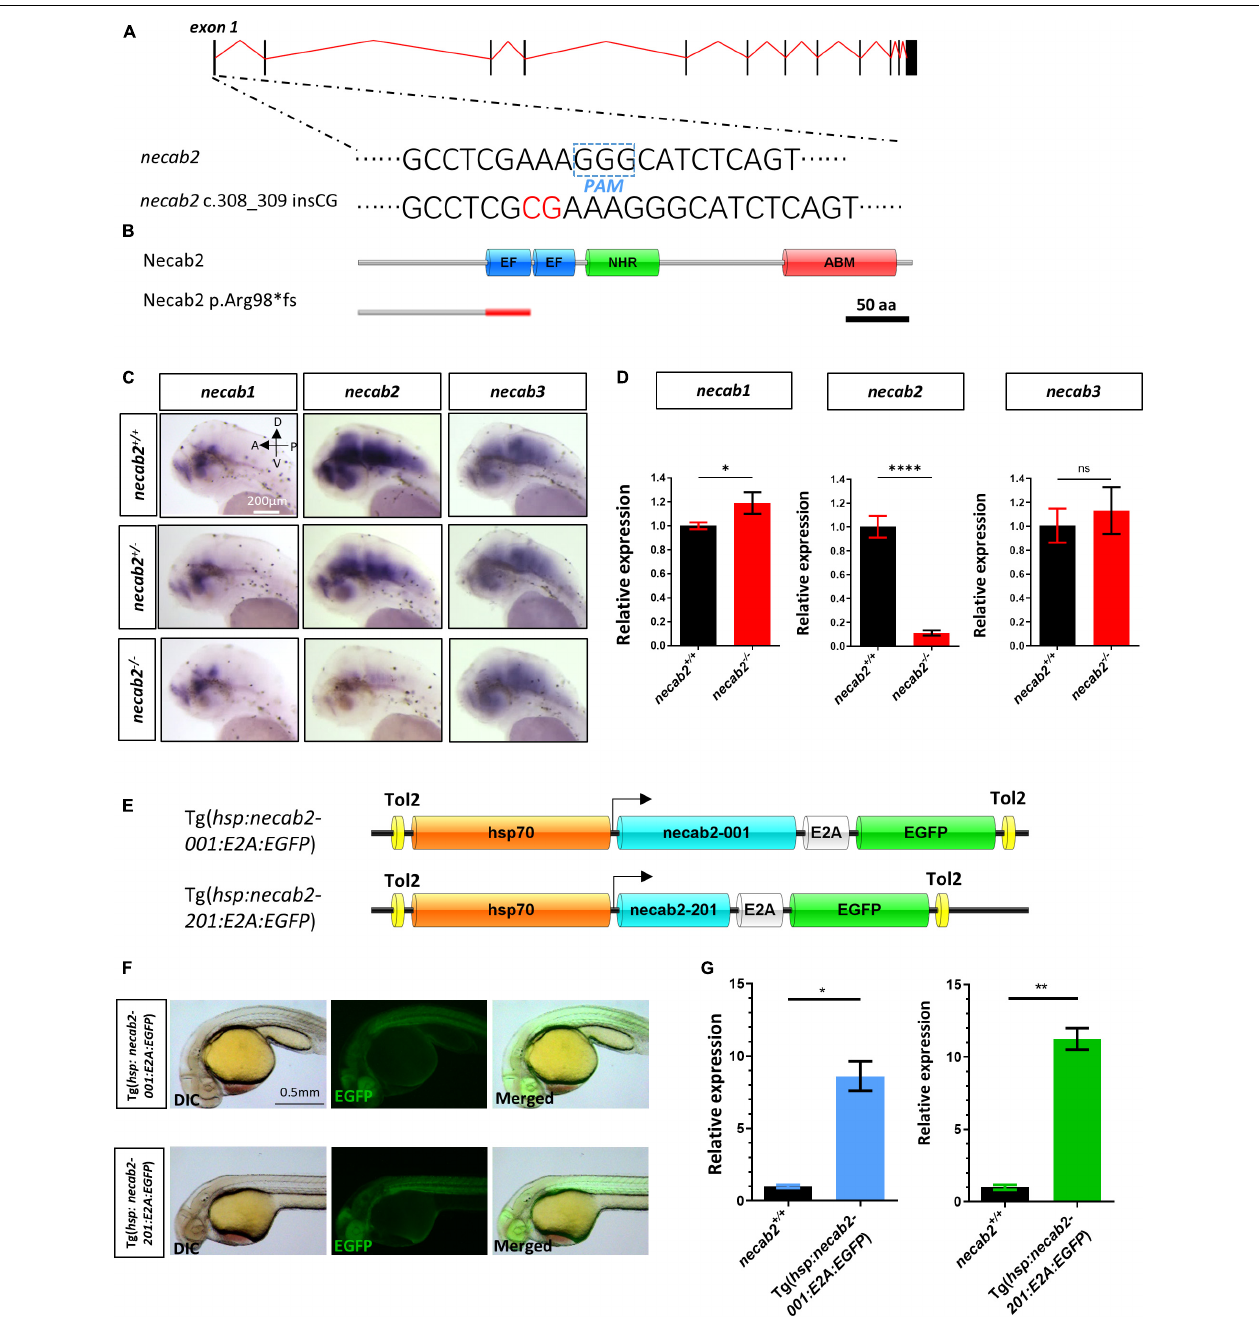
FIGURE 3 | Generation of a necab2 mutant via CRISPR/Cas9 and necab2 over-expression lines by Tol2 transgenesis. (A) Schematic presentation of the genomic structure of necab2 and a 2 bp insertion in exon1 generated by gene targeting via CRISPR. The PAM site was highlighted in the dashed blue box. The inserted base was shown in red. (B) Predicted structures of Necab2 + / + and Necab2 − / − proteins in zebrafish. The 2 bp insertion in exon 1 resulted in a frame-shift mutation and premature termination before the EF-hand domain. (C) Spatial analysis of necab1 , necab2 , and necab3 mRNA by whole-mount in situ hybridization was performed blindly in the embryos derived from the in-cross of necab2 + / − followed by genotyping. Scale bar = 200 µ m. (D) Quantitative analysis of necab1 , necab2 , and necab3 mRNA by qRT-PCR. The mRNA of necab3 did not show a significant compensation effect while the upregulation of the necab1 mRNA reached statistical significance. (ns p ≥ 0.05, * p < 0.05, **** p < 0.0001, Student’s t -test or Mann-Whitney U test). (E) Schematic presentation of the Tol2 transgenic construction of Tg( hsp:necab2-001:E2A:EGFP ) and Tg( hsp:necab2-201:E2A:EGFP ). (F) Fluorescent imaging of the transgenic fish Tg( hsp:necab2-001:E2A:EGFP ) and Tg( hsp:necab2-201:E2A:EGFP ). Fish were processed for 37 ◦ C heat-shock for 1 h at 1 dpf. Scale bar = 0.5 mm. (G) Quantitative analysis of the necab2 mRNA in Tg( hsp:necab2-001:E2A:EGFP ) and Tg( hsp:necab2-201:E2A:EGFP ) against their wild-type counterparts respectively by qRT-PCR. (* p < 0.05, ** p < 0.01, Student’s t test or Mann–Whitney U test.) dpf, day